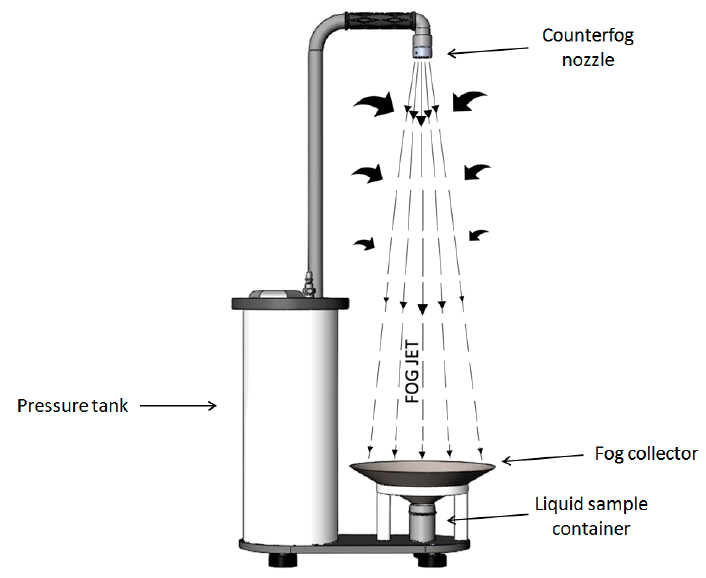
Figure 1. Operating principle of the Counterfog BIAFTS technology.